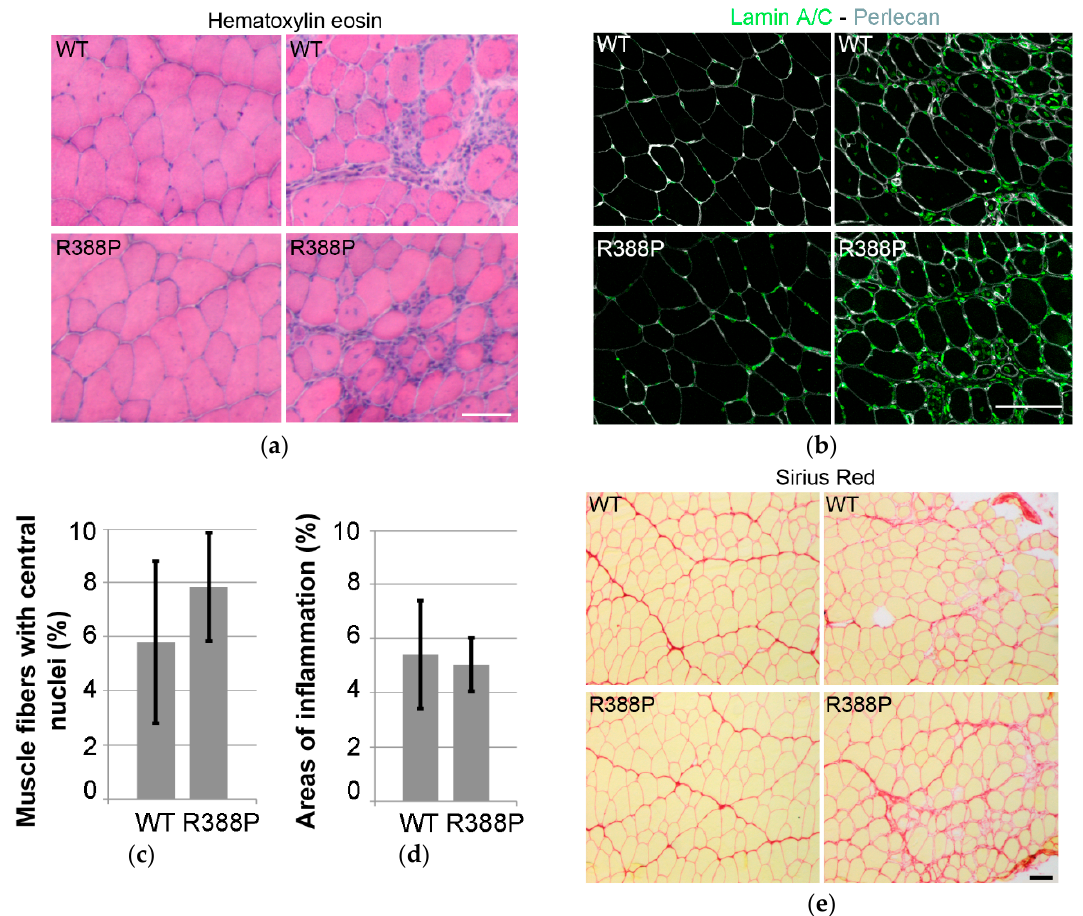
Figure 2. Inflammation, regeneration, and fibrosis in mouse TA muscles expressing AAV-mediated lamin A. ( a ) examples of hematoxylin and eosin staining of transverse muscle sections expressing WT (upper) or R388P mutant (lower) lamin A. ( b ) in situ detection of A-type lamins (ectopic and endogenous; green) and perlecan (grey) on transverse muscle sections expressing WT or R388P lamin A. ( c ) mean percentage ± s.e.m. of myofibers with central nuclei ( n = 6–7). ( d ) mean percentage ± s.e.m of muscle section areas showing patterns of inflammation ( n = 7–8). ( e ) examples of Sirius Red staining of transverse muscle sections expressing WT (upper) or mutant (lower) lamin A. Scale bars represent 100 μ m.